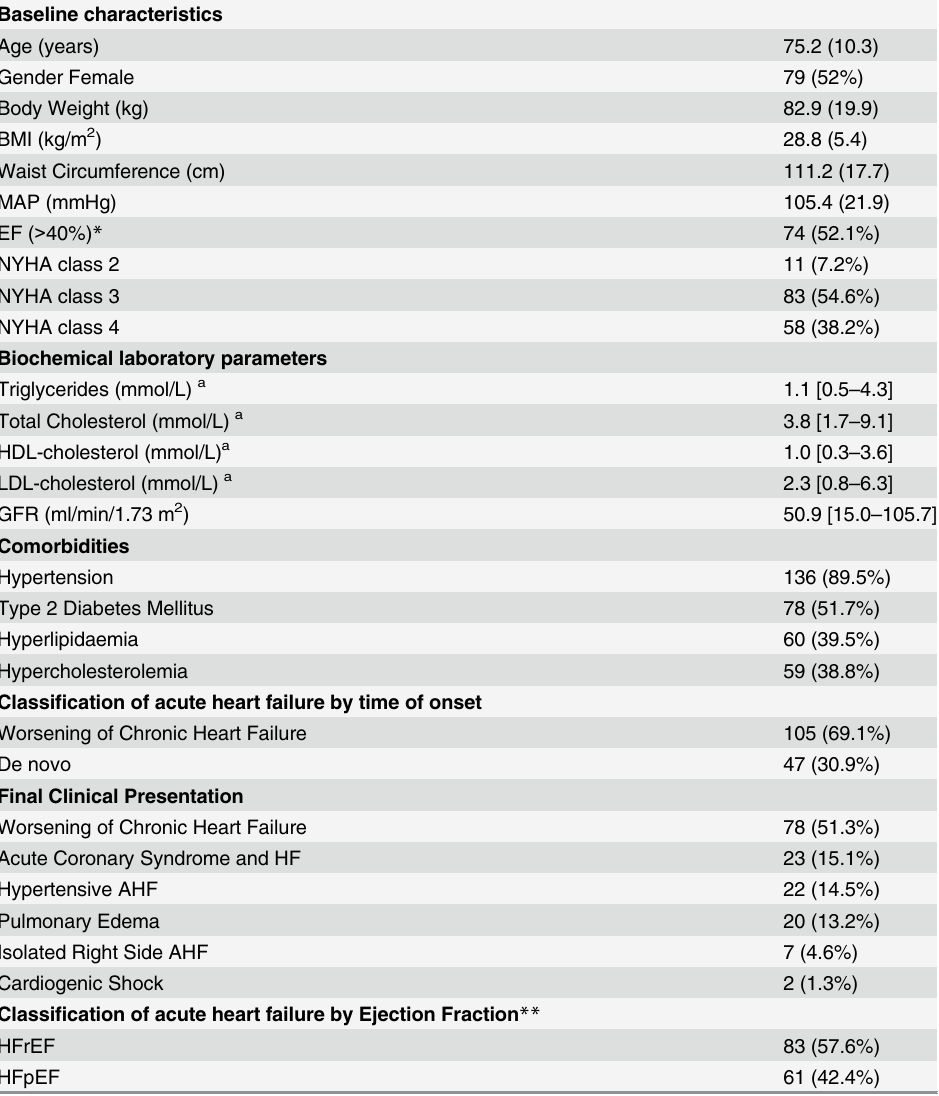
Table 1. Baseline characteristics, biochemical laboratory parameters, comorbidities, and classifica- tion of AHF patients (n =